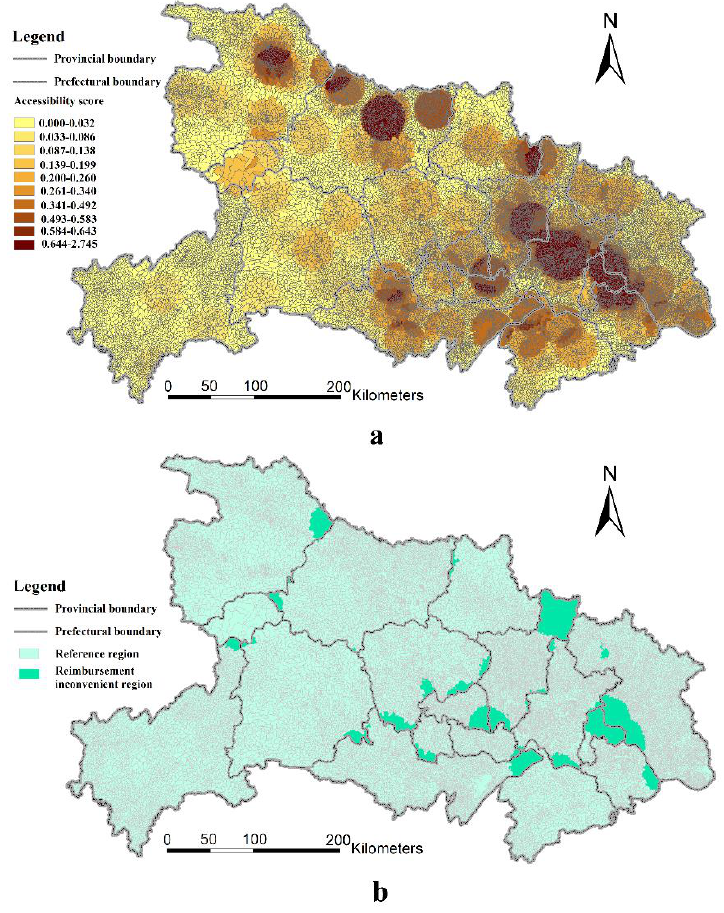
Figure 5. Accessibility ratios to Grade-B hospitals ( a ), and the geographical distribution of reimbursement inconvenience regions with respect to Grade-B hospitals ( b